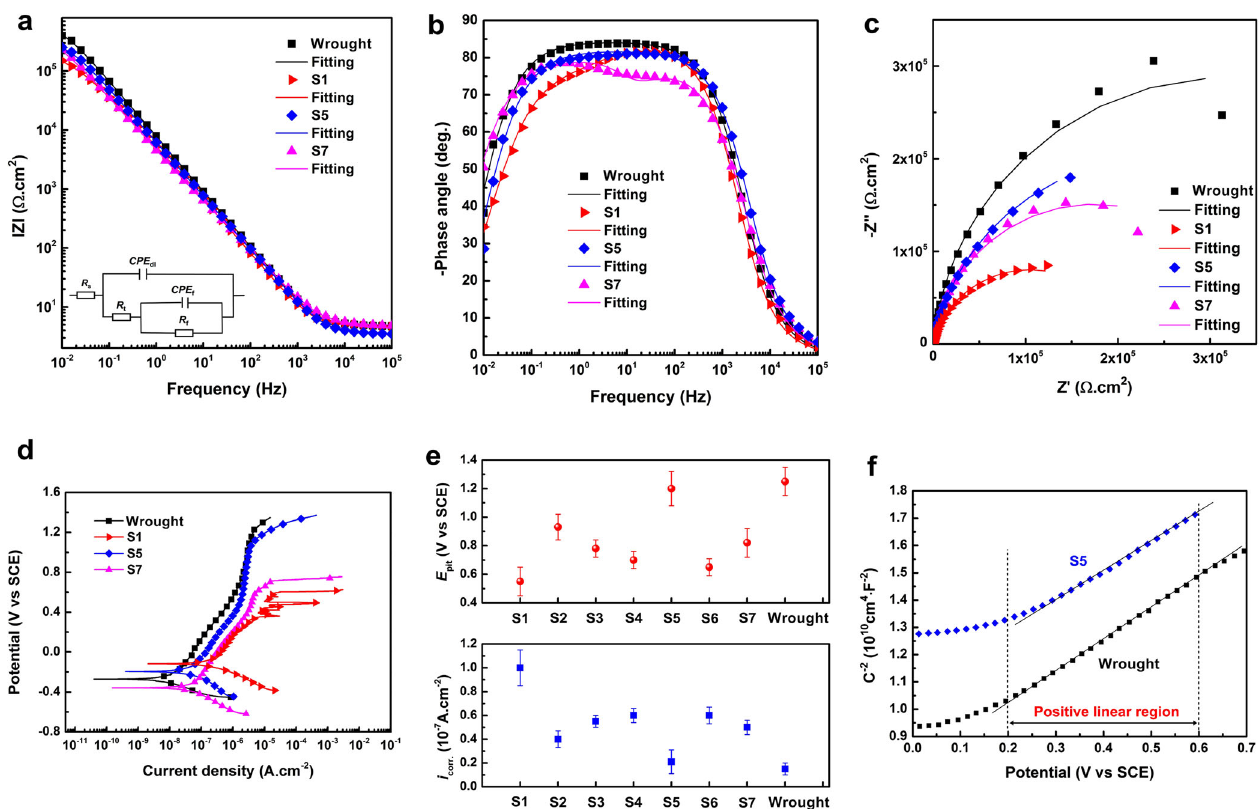
Fig. 3 Electrochemical curves of EBM NiTi alloys with different fabrication parameters. a Frequency-impedance plots (the insert diagram referring to the equivalent circuit of EIS), b frequency-phase angle plots, c Nyquist plots, d potentiodynamic polarization plots of S1, S5, S7 and the wrought NiTi alloy, e distribution of E pit and i corr of different EBN NiTi alloys for six experiments, and f the Mott – Schottky curves of S5 and the wrought NiTi alloy. Table 1. Electrochemical parameters obtained by fi tting EIS curves for the wrought alloy, S1, S5, and S7.